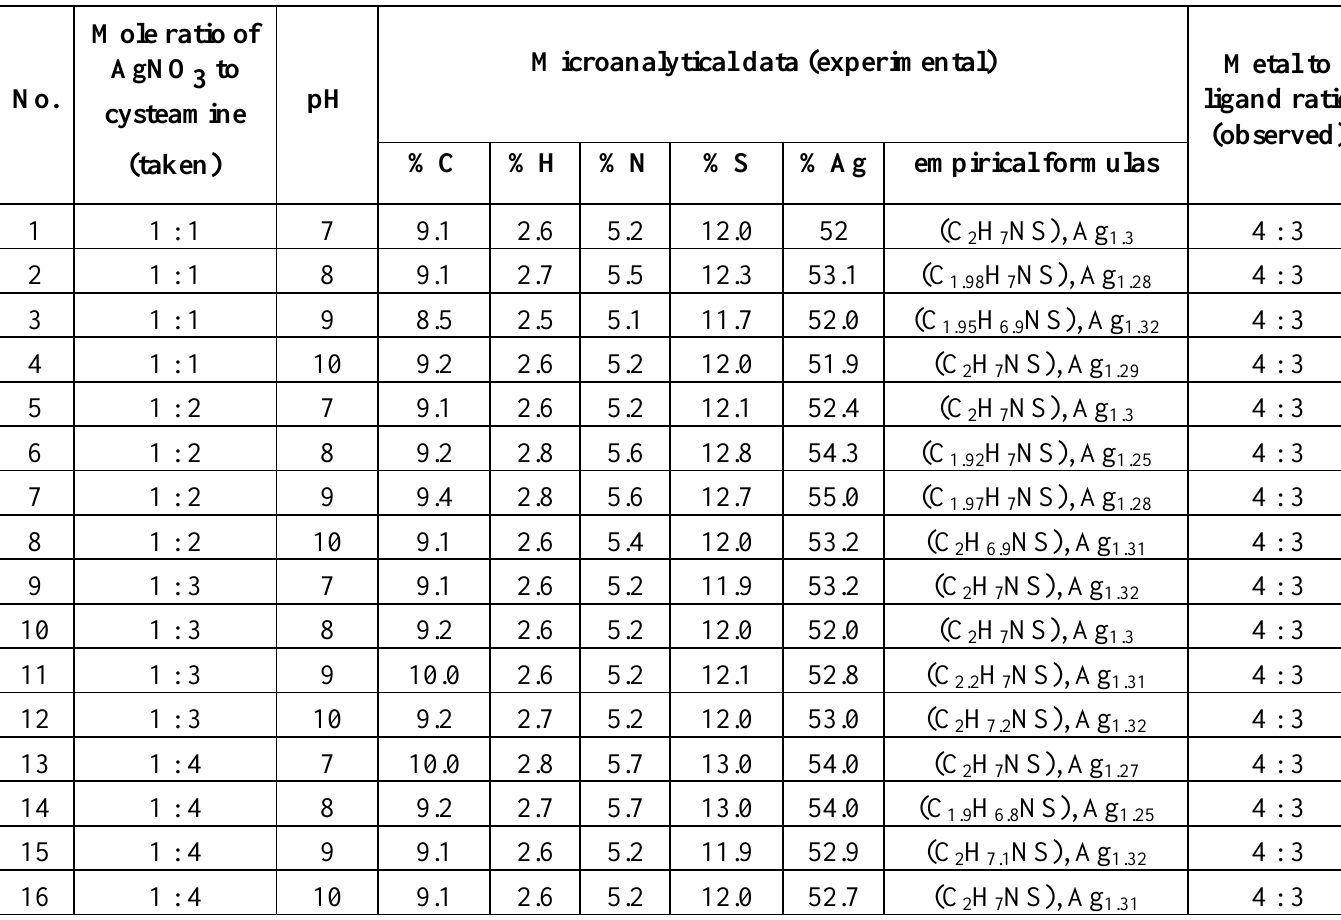
Table 1. Microanalysis data for the complexes prepared with different mole ratios of silver nitrate to cysteamine, at different